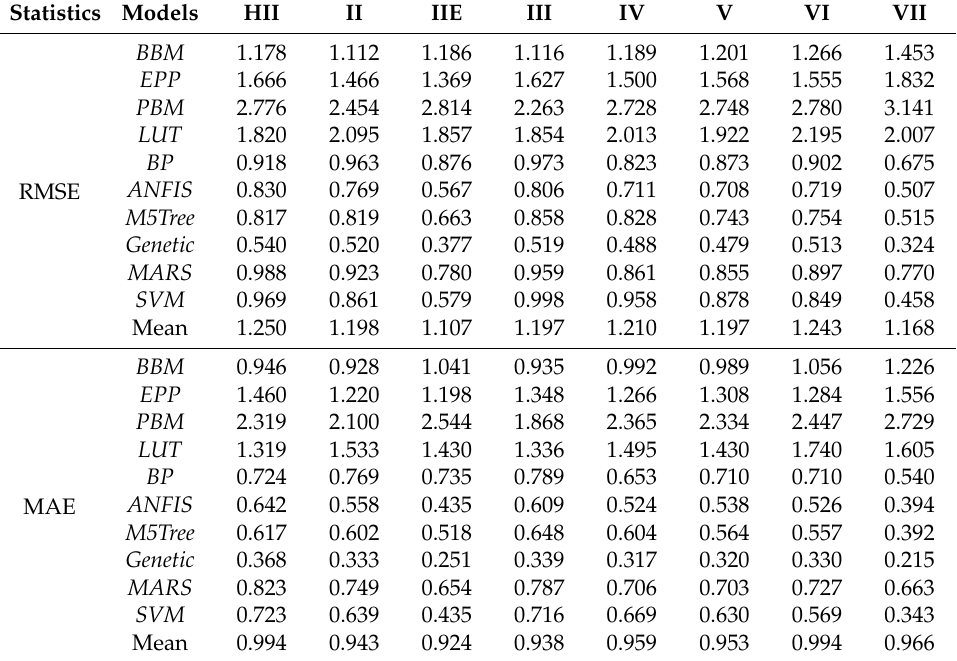
Table 3. The root mean square error (RMSE) and mean absolute bias error (MAE) for the PAR models in different temperate